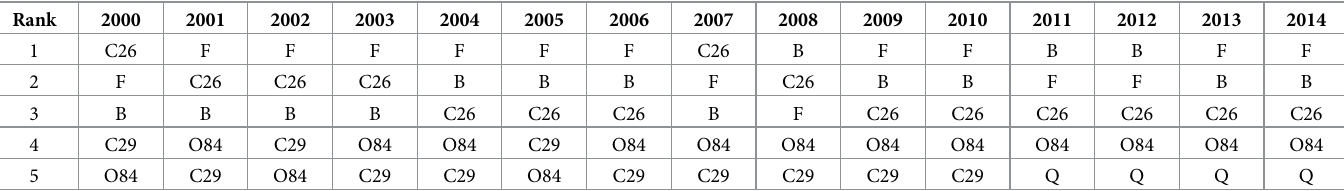
Table 14. Five highest-circulated sectors in the Pacific Rim